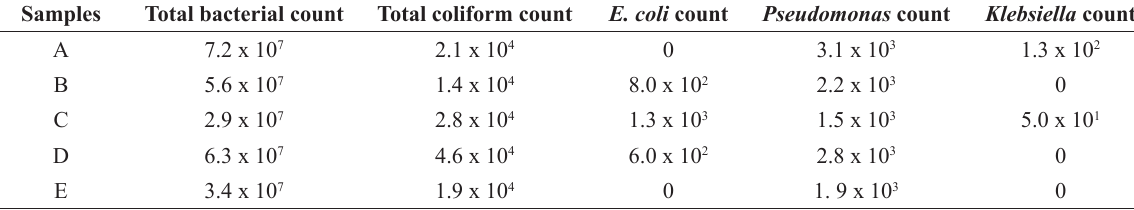
Table 1: E numeration of different bacterial isolates (cfu/ml). Samples Total bacterial count Total coliform count E. coli count Pseudomonas count Klebsiella